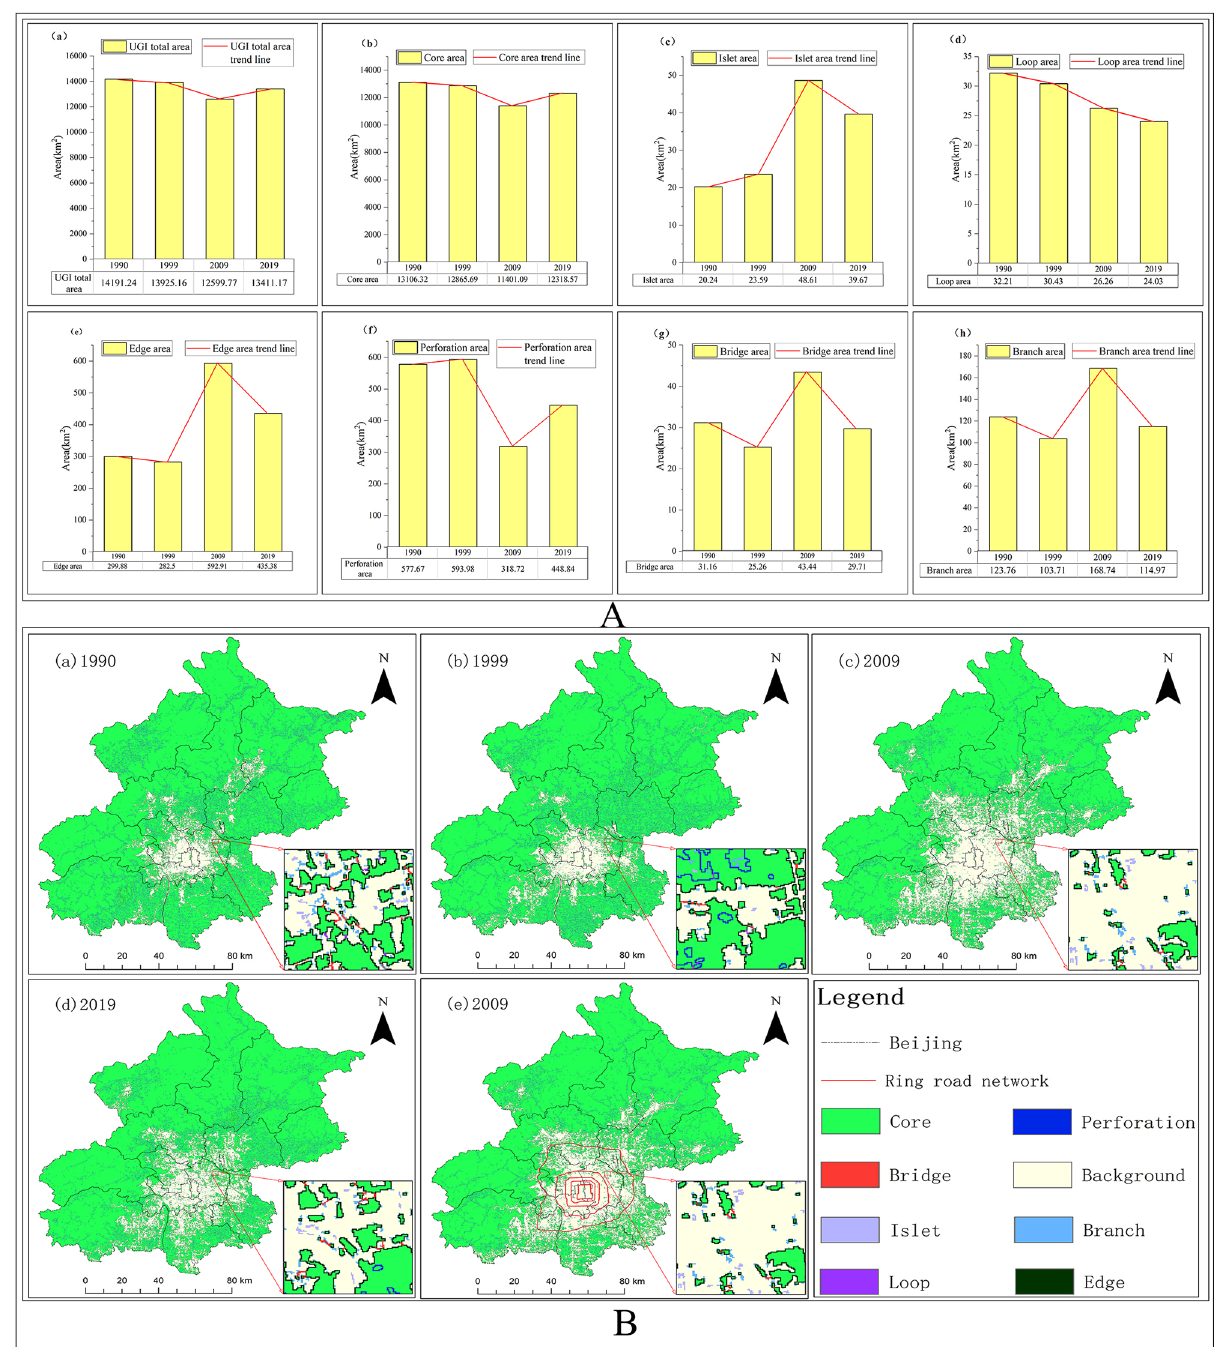
Figure 1. Spatio-temporal evolution of UGI in Beijing from 1990 to 2019. ( A ) Area variation of categories of UGI in Beijing from 1990 to 2019. ( B ) Distribution of UGI in Beijing from 1990 to 2019 and overlay map of UGI and sixth ring road network in 2009. The figure was drawn with ArcGIS sofware version 10.4. (https:// www. esri. com/ en- us/ arcgis/ produ cts/ arcgis- deskt op/ overv iew).